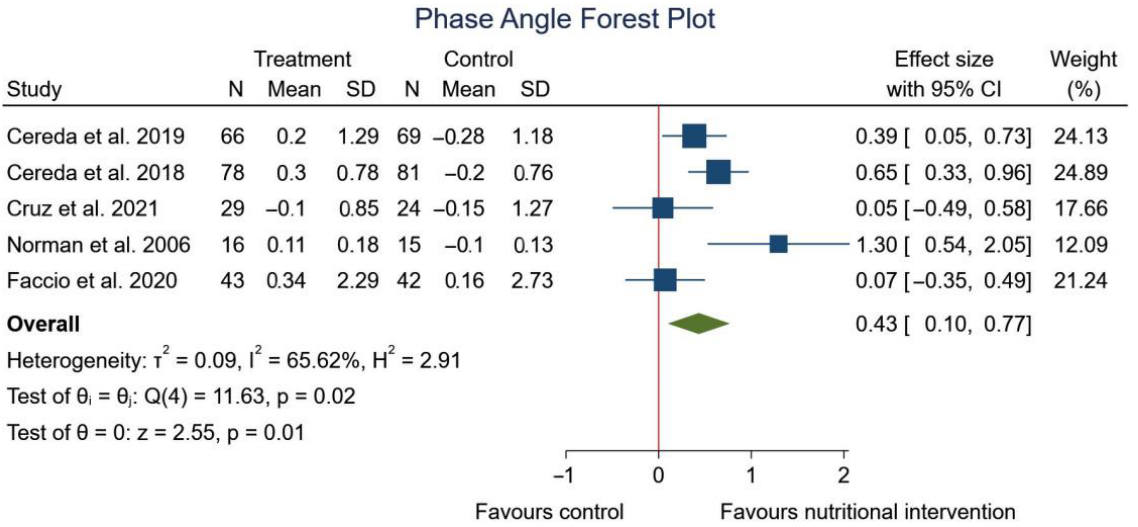
8 of 15 Figure 3. Graph of RoB 2.0 for each study according to the five domains defined by Cochrane for intention to treat studies [39,40,55]. 3.4. Findings from Meta-Analysis Four meta-analyses were conducted to test the effects of different types of nutritional